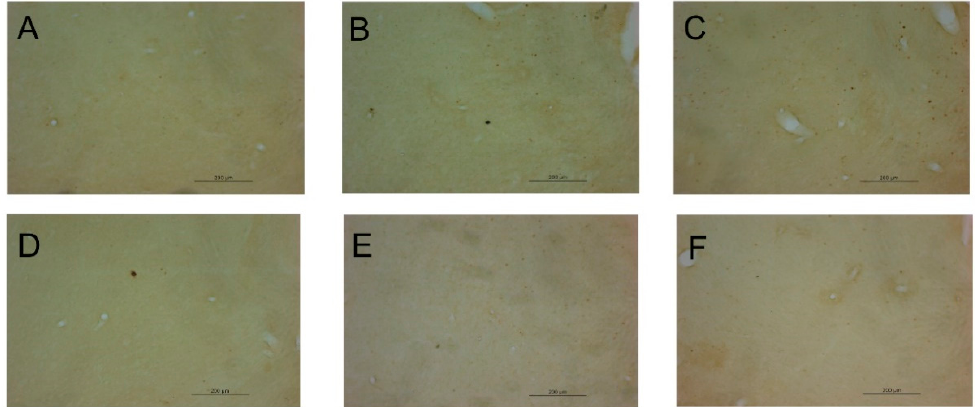
Figure 2. Representative images of coronal sections of the NAcc after cFOS staining in experiment 1. Legend: ( A ) group Veh/Saline; ( B ) group NAC 30/Saline; ( C ) group NAC 120/Saline; ( D ) group Veh/MTEP; ( E ) group NAC 30/MTEP; ( F ) Group NAC 120/MTEP.